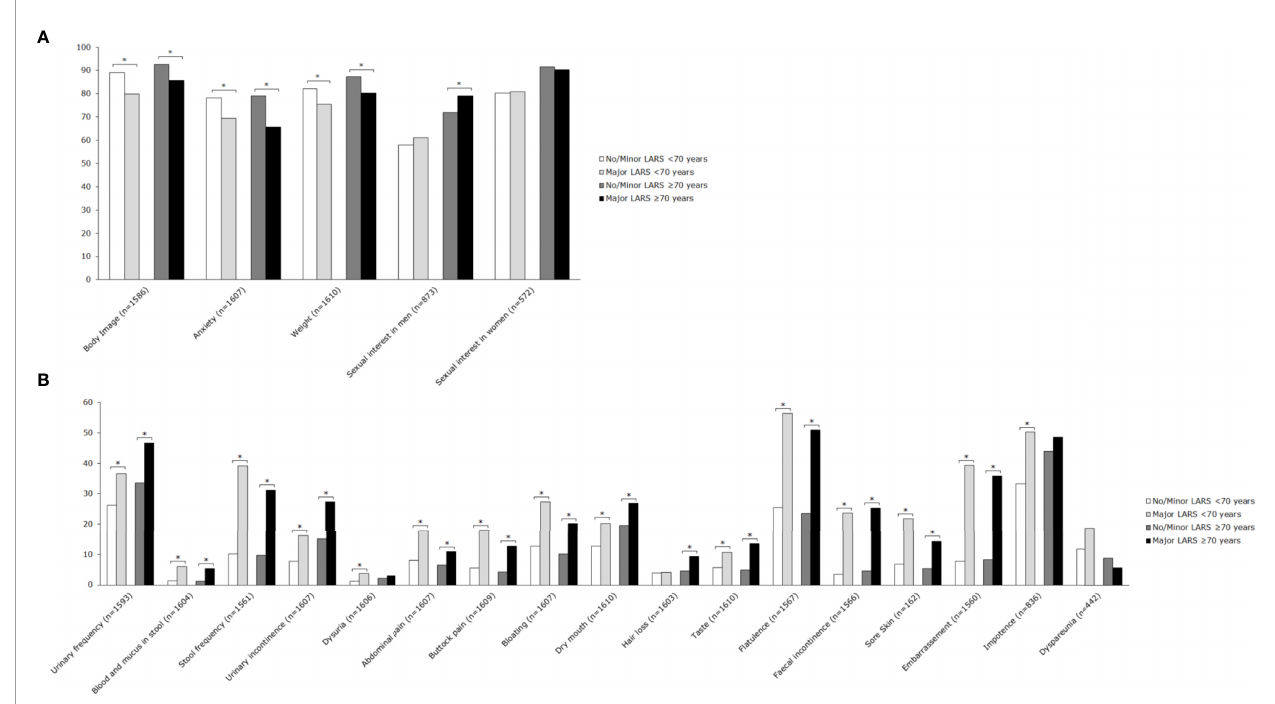
FIGURE 4 | Mean scores of EORTC QLQ-CR29 subscales for patients <70 years and ≥ 70 years, strati fi ed by LARS group. (A) Functional scales: A higher score represents a better level of functioning. (B) Symptom scales: A higher score represents a higher level of symptoms. Signi fi cant differences are indicated by an asterisk; p -value <